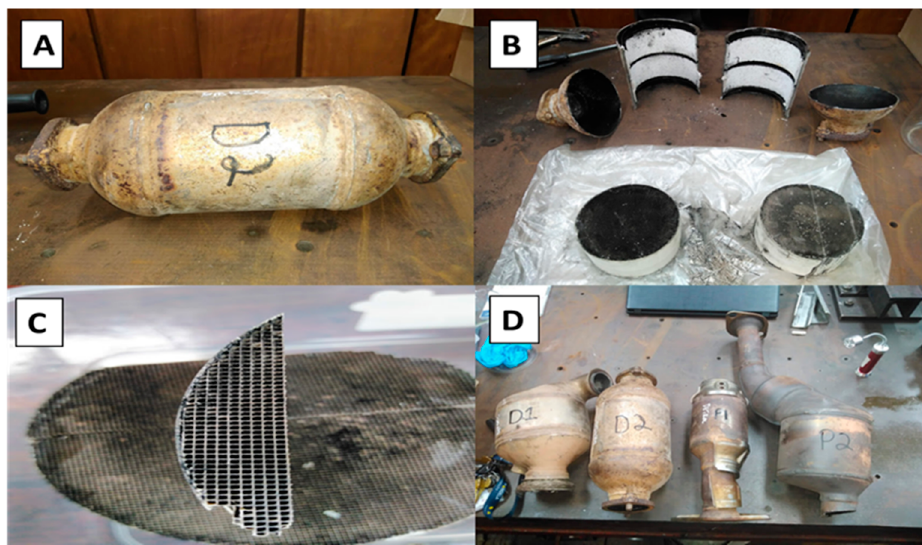
Figure 3. ( A ) Spent diesel catalytic converter before dismantling. ( B ) Spent catalytic converter after dismantling. ( C ) Zoomed-in image of the ceramic catalytic converter. ( D ) Spent catalytic converters where ( D ) represents diesel and P represents petrol type.